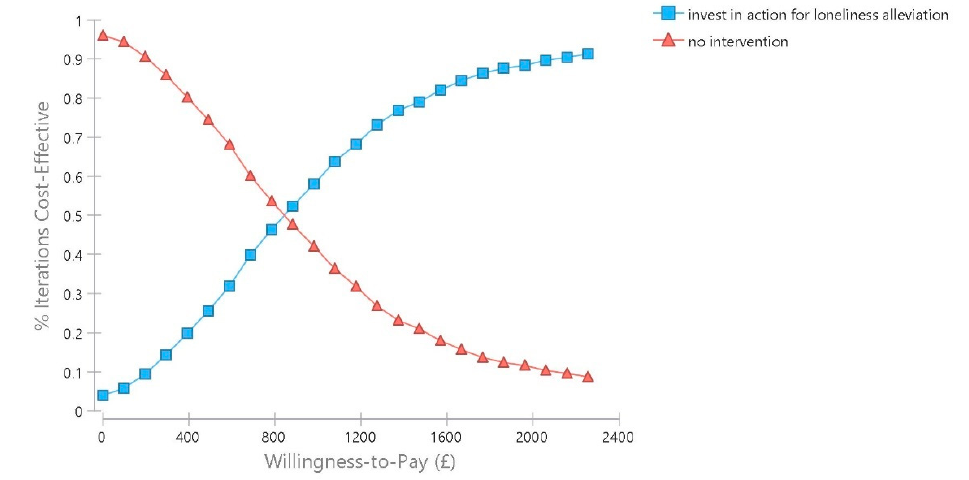
Figure 5. Cost-effectiveness acceptability curve.